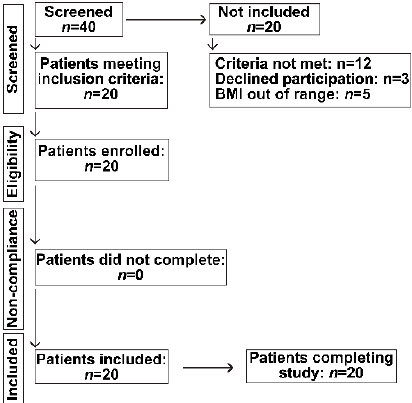
Figure 1. Flow chart of recruitment of participants according to the Consort statement.